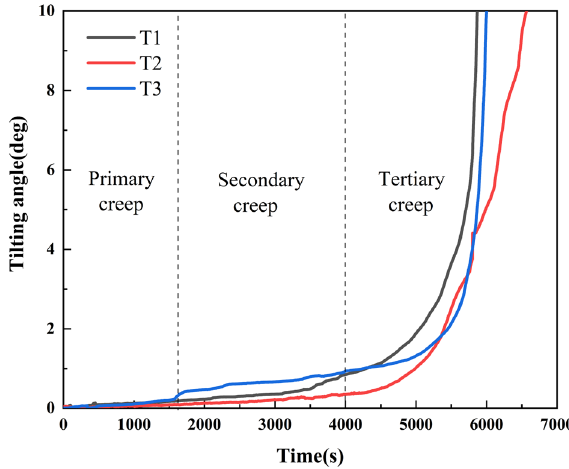
Figure 2. Tilting deformation curve of landslide.